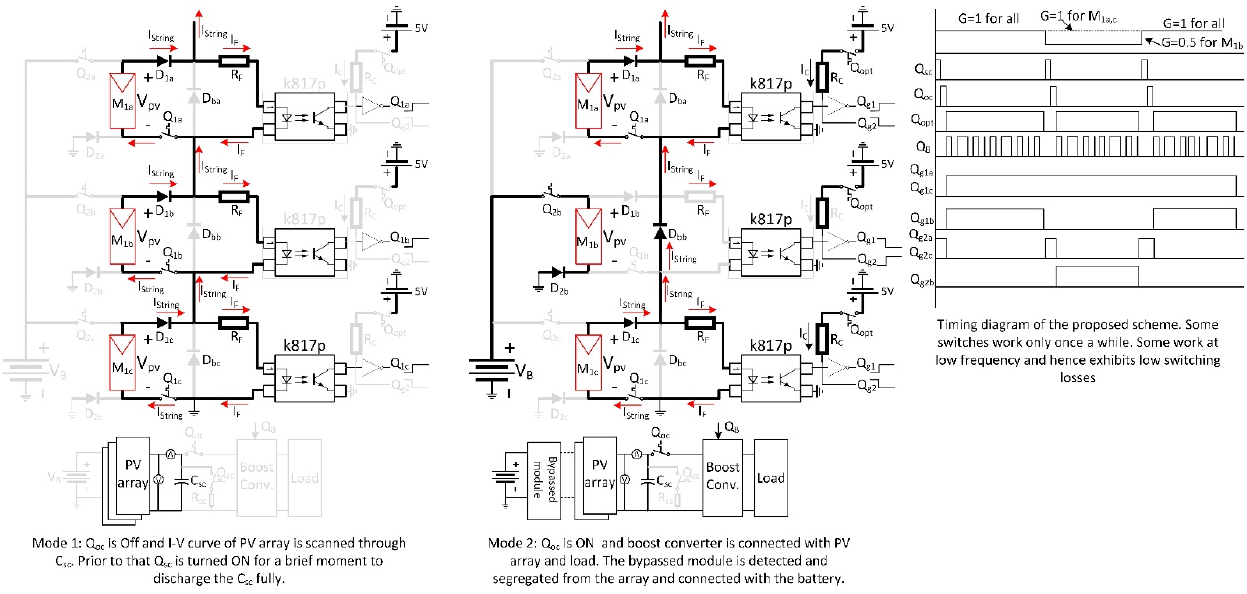
Figure 5. Modes of operation with global MPPT tracking .